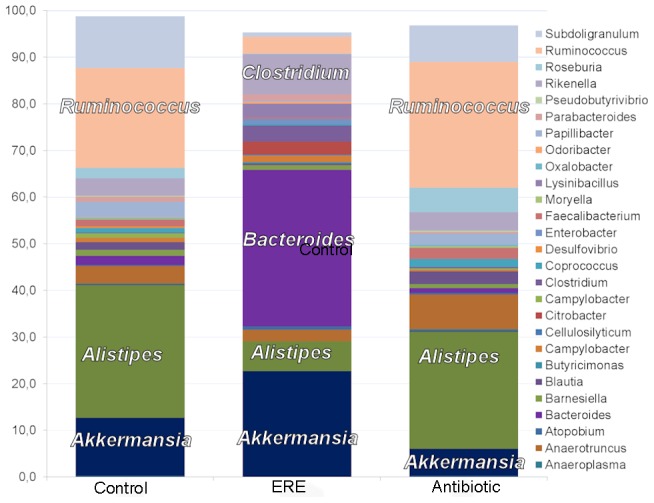
Proportional piled up column graph representing the average abundance of the different bacterial genera for the control group (healthy, no antibotics) (C), rabbits treated with antibiotics (A) and ERE animals (E).Most abundant genera are marked on the bar.